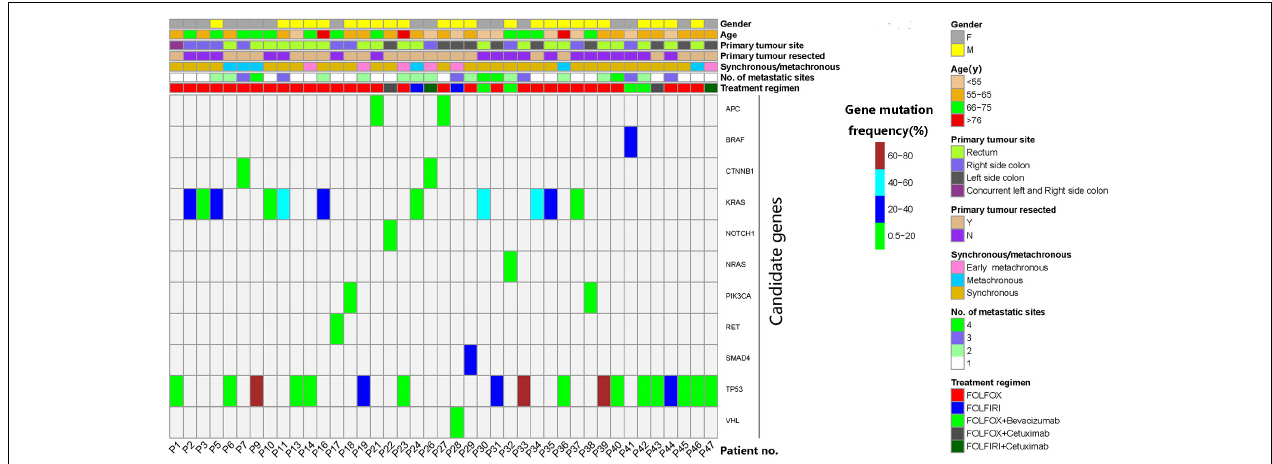
FIGURE 2 | Characteristics and candidate mutations of the 41 patients who were eligible for serial monitoring of circulating tumor DNA (ctDNA). Mutation of the maximal frequency in pretreatment ctDNA was selected as each patient’s candidate mutation. Early metachronous metastasis meant metastasis diagnosed within 12 months of the primary